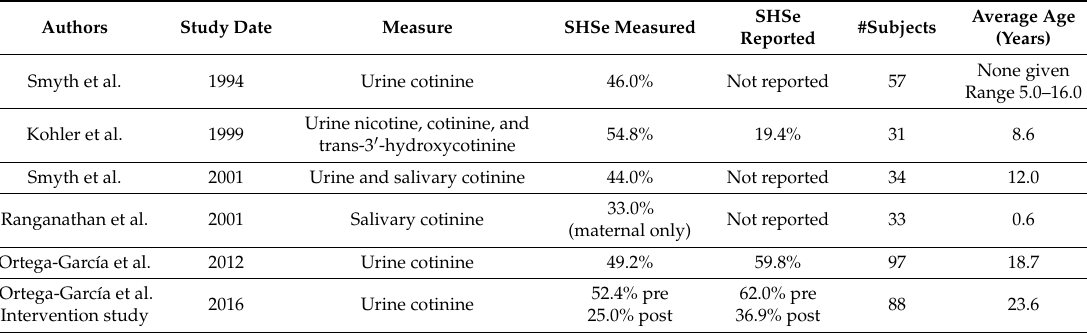
Table 1. Summary of studies with quantification of tobacco metabolites in cystic fibrosis